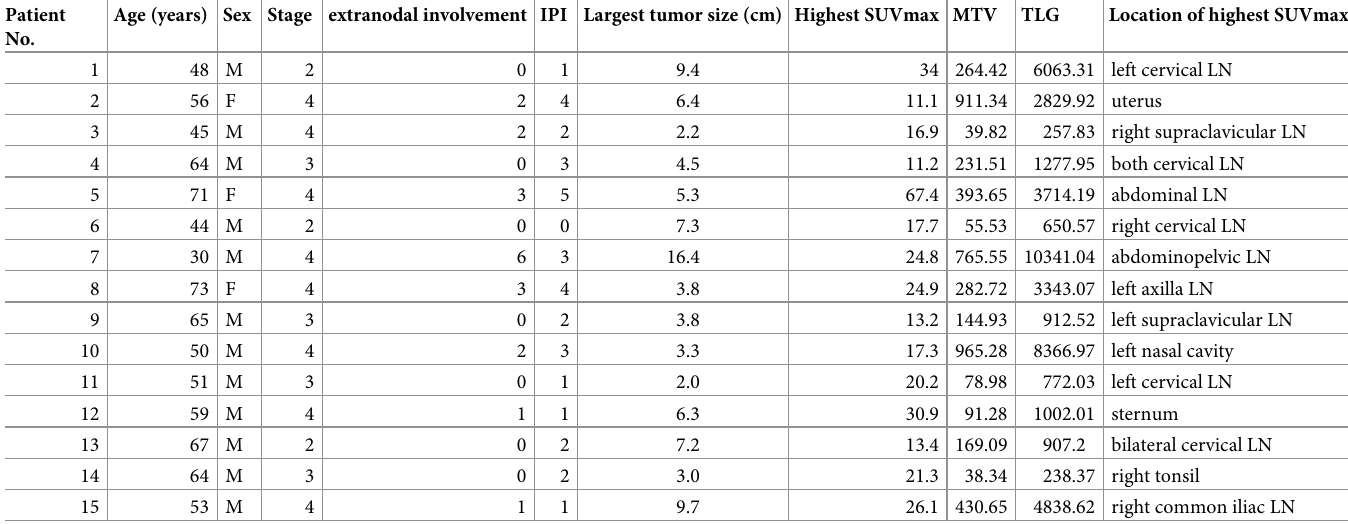
Table 1. Clinical characteristics of